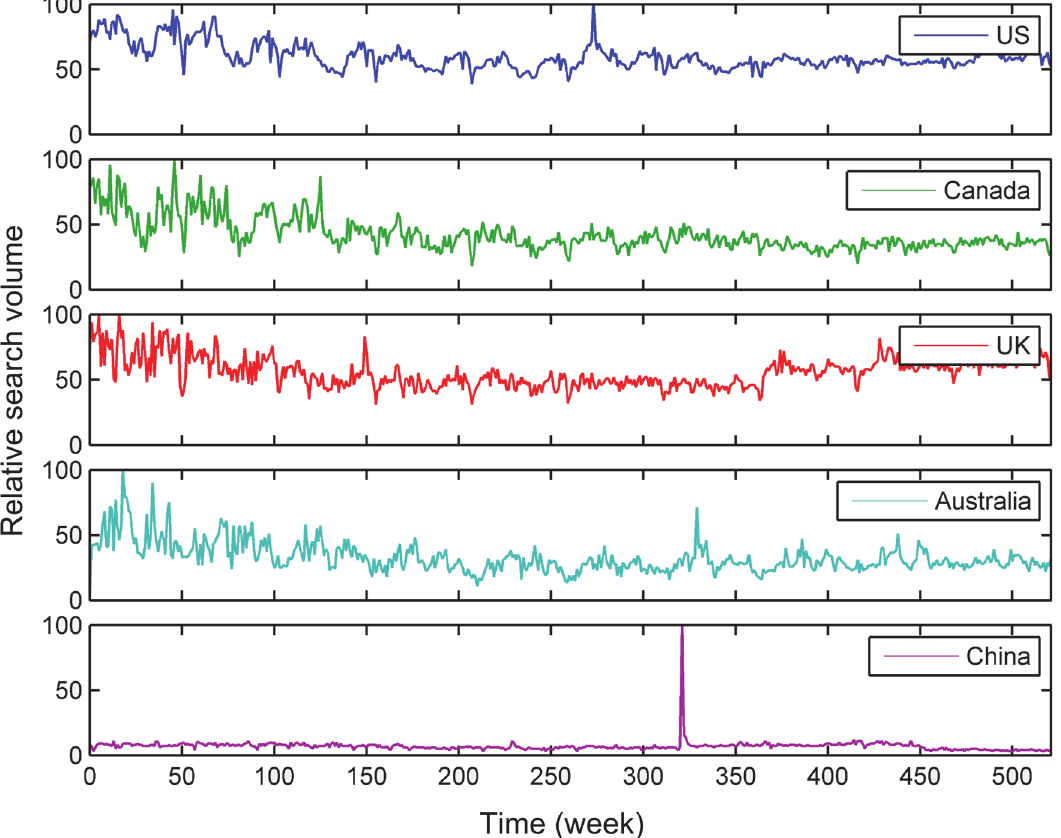
Fig 1. Raw search trends regarding tobacco from Google Trends. It contains the trends of the USA, Canada, the UK, Australia, and China. The time interval contains 522 weeks from January 4, 2004 to January 4,